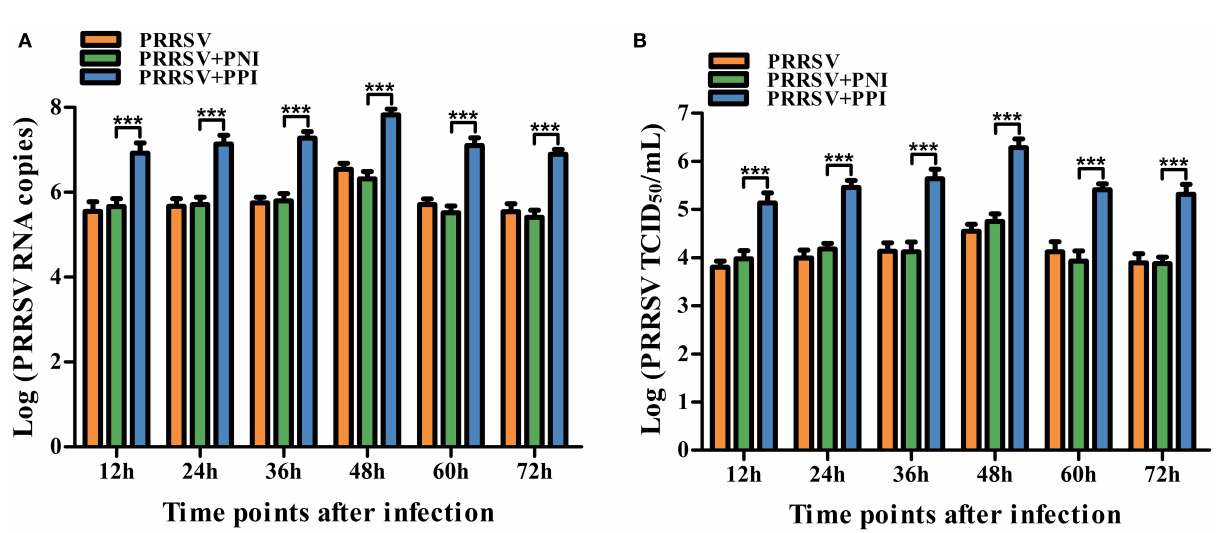
FIGURE1 Detection of PRRSV-ADE activity in PAMs. PRRSV RNA (A) and TCID 50 (B) in harvested culture supernatants of the PAM cells following PRRSV, PRRSV + PPI, or PRRSV + PNI infection were measured using real-time RT-PCR and viral titration experiments. The bars indicate the RNA copies or TCID 50 titers of PRRSV. The error bars indicate the mean ± standard error of the mean (SEM) from three independent experiments. *** p <